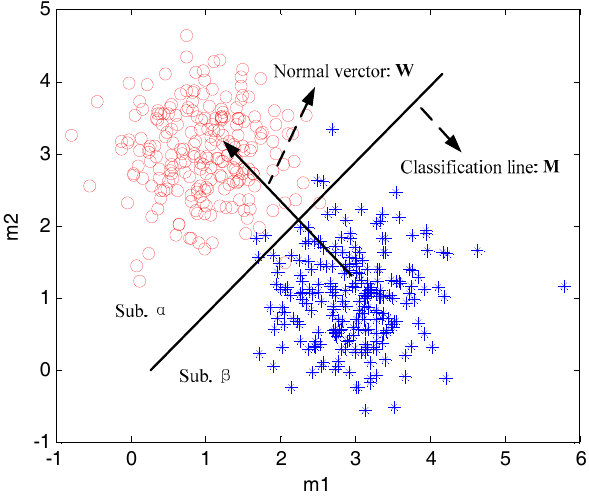
Figure 3. The optimal classification line to classify two groups of data in two dimension space.